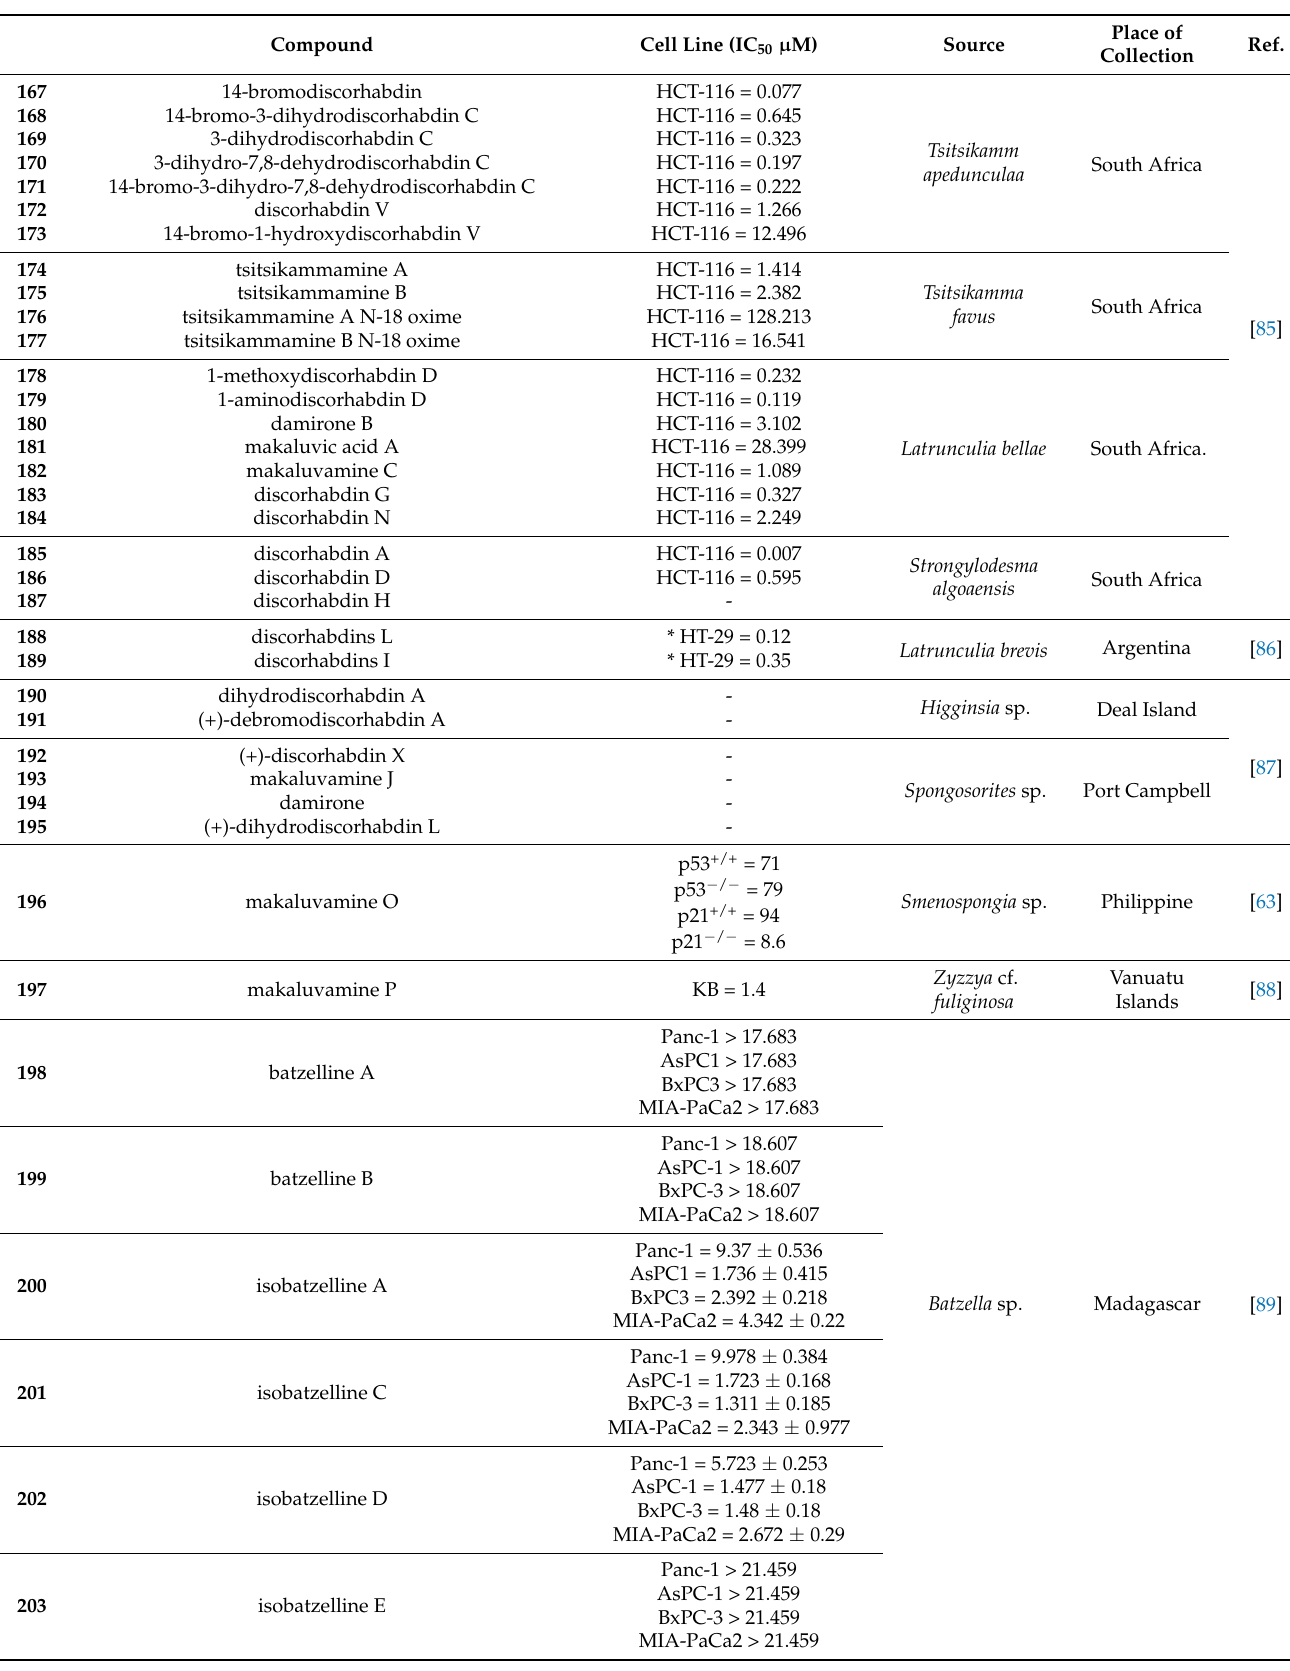
Table 14. Cytotoxic activity of pyrroloiminoquinone alkaloids in sponges.